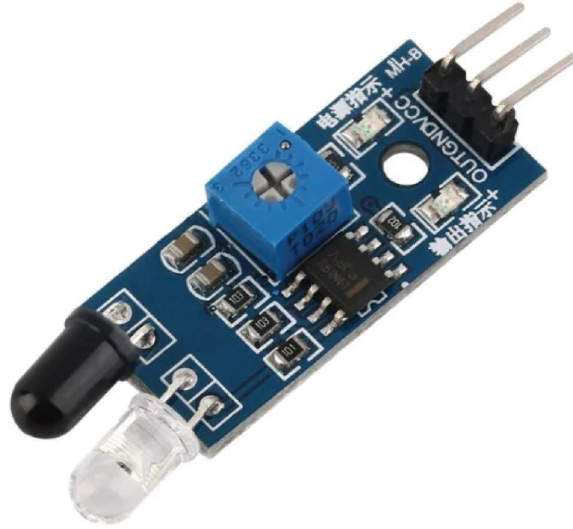
Figure 4: Infrared